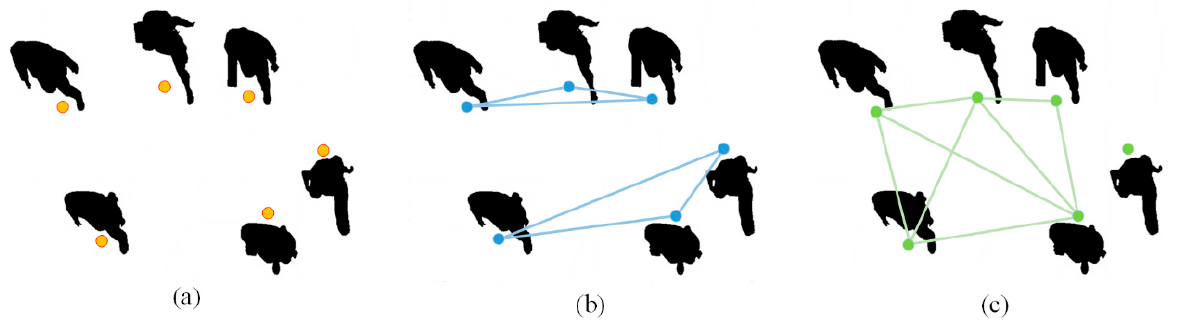
Figure 2. Illustration of Spatial interaction of multi-pedestrians. ( a ), each pedestrian is considered independently as an aggregate; ( b ), three people are considered as an aggregate; ( c ), five people are considered as an aggregate.